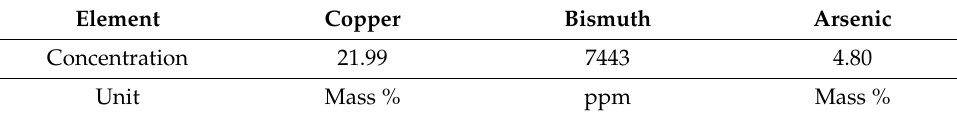
Table 1. Concentration (by mass) of Cu, Bi, and As in FF-ESP dust. Element